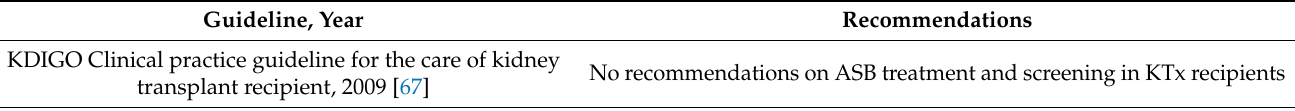
Table 2. Published guidelines on management of asymptomatic bacteriuria (ASB) in KTx